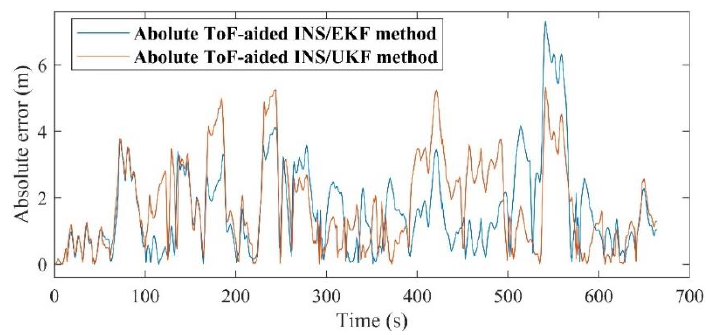
Figure 17. ( a ): The reference map for trajectory of the second scenario, ( b ): the comparison of 2D positioning results for ToF-aided INS/EKF and INS/UKF methods.